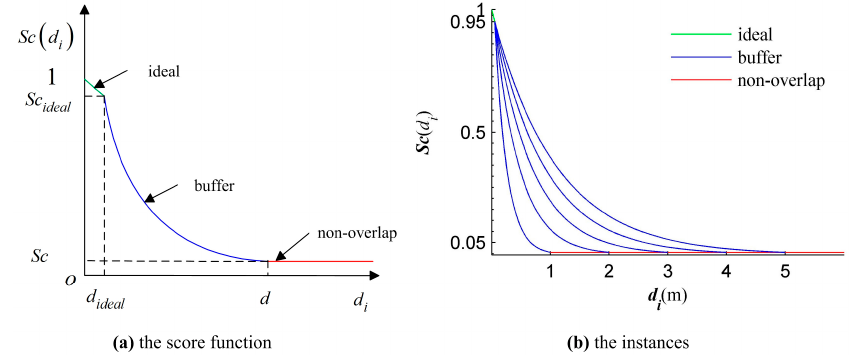
Figure 4. The score function and its instances. ( a ) The diagram of score function; ( b ) the instances of score function under different distance thresholds.